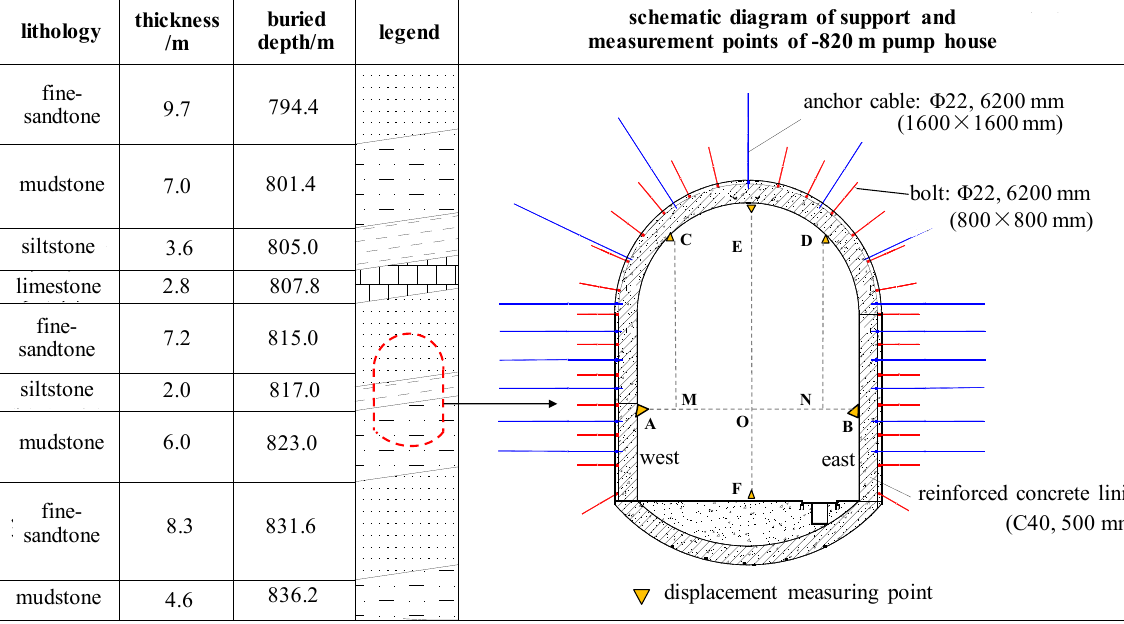
Figure 2. The support and rock distribution of the pumping house.